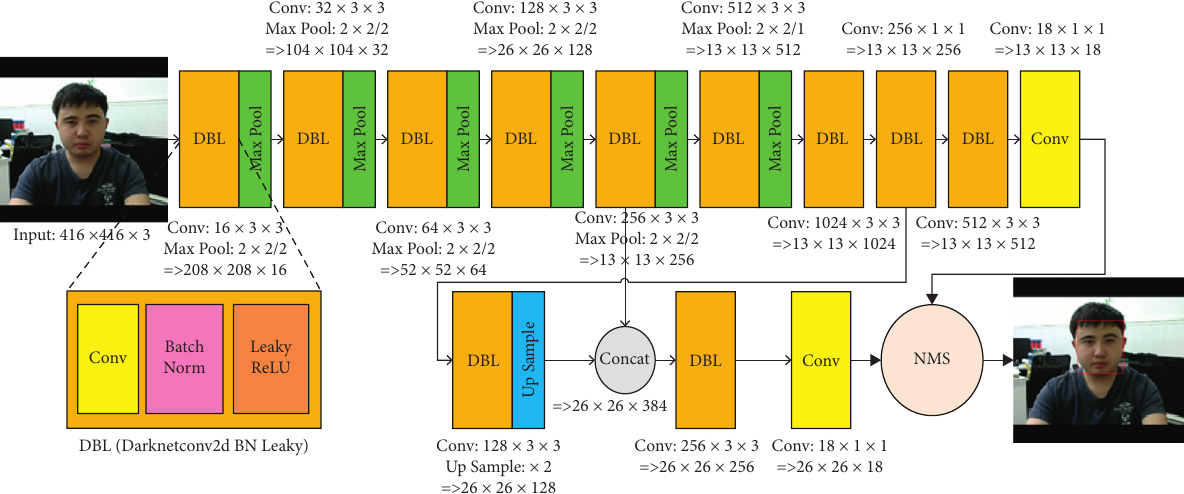
Figure 2: Improved YOLOv3-tiny network structure